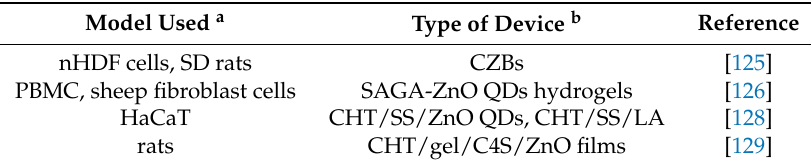
Table 6. ZnO nanoplatforms for wound